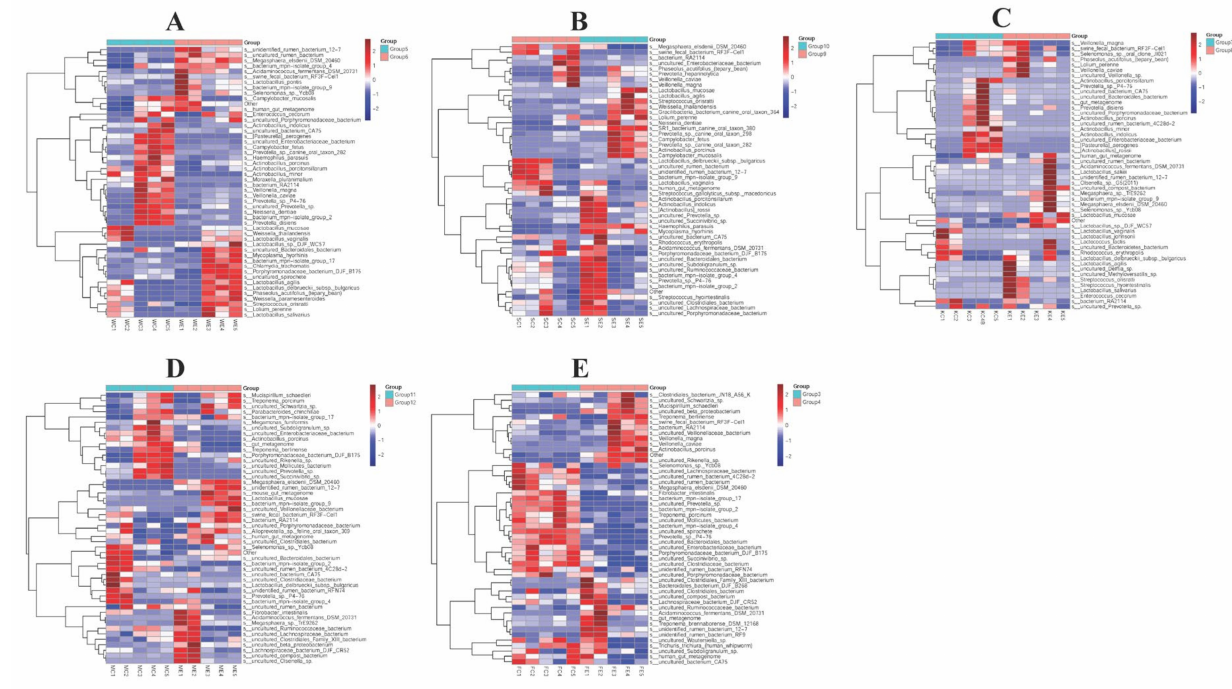
Figure 6. Heatmap showing the efficacy of colistin on piglet microbiome change at species levels. ( A ) Stomach (Group 6, Group 5); ( B ) duodenum (Group 10, Group 9); ( C ) jejunum (Group 8, Group 7); ( D ) cecum (Group 12, Group 11); ( E ) feces (Group 4, Group 3); the colistin treated group: